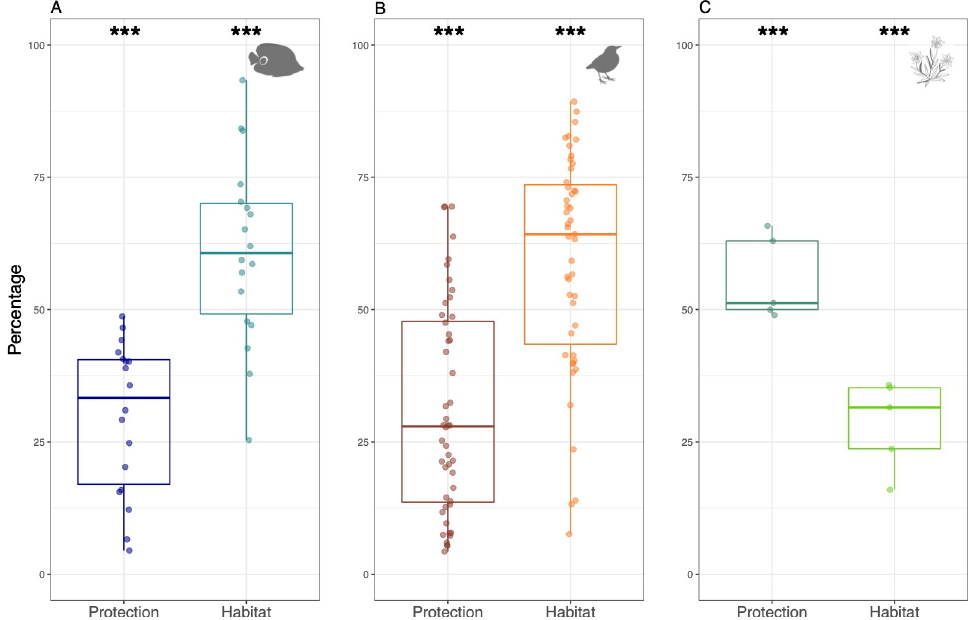
Fig 2. Result of the partial dbRDAs. Marginal effect of protection and environmental conditions to observed turnover between Strictly Protected areas surveys and surrounding surveys within a 50-km buffer (from non-protected areas and/ or restricted areas ( n = 18, 131, 5) for reef fishes ( A ), birds ( B ), and alpine plants ( C ). Some Strictly Protected areas were removed because environmental conditions were strictly identical between surveys making impossible comparison of the relative contribution of both protection and environmental conditions. Asterisks indicate the Fisher p -value, denoting the combined partial effect of protection and environmental conditions for each taxon using permutation ANOVA, i.e., whether or not each environment and protection level had a significant association with observed species turnover. The raw data can be found in